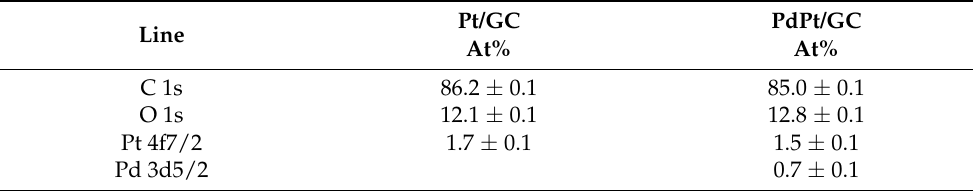
Table 1. Atomic percentage of the elements for Pt/GC and